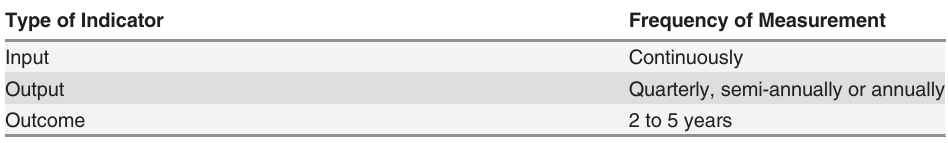
Table 2. Types of indicators and recommended frequency of measurement *